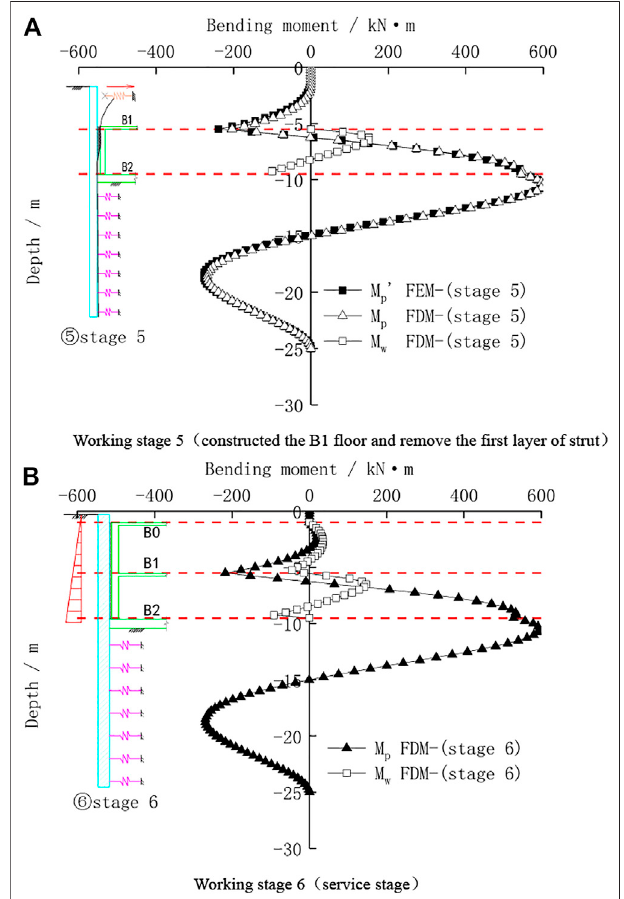
FIGURE 8 | Bending moment of the pile wall combination structure during construction and service stage of the basement. (A) Working stage 5 (ConstructingtheB1 fl oorandremovingthe fi rstlayerofthestrut). (B) Working stage 6 (Service